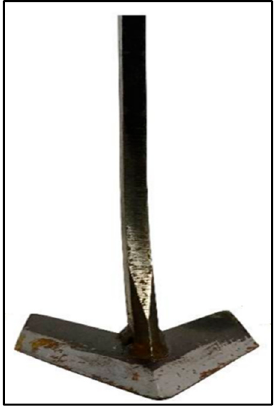
Figure 3. No-till sweep with a modified working width of 100 mm in 2018 respectively 90 mm in 2019 and 2020 (modified from Machleb et al.) [21].